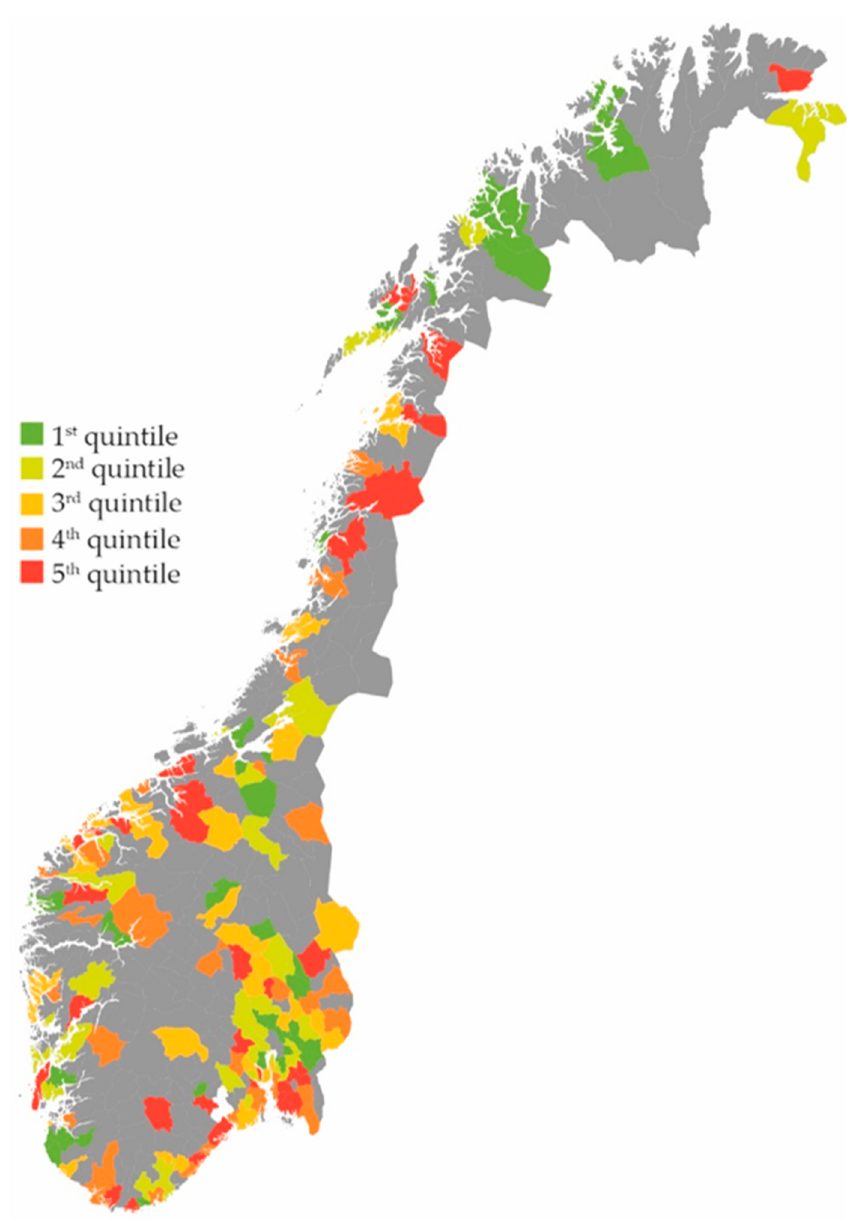
Figure 3. RTI antibiotic prescriptions per 1000 RTI consultations in 198 Norwegian municipalities.